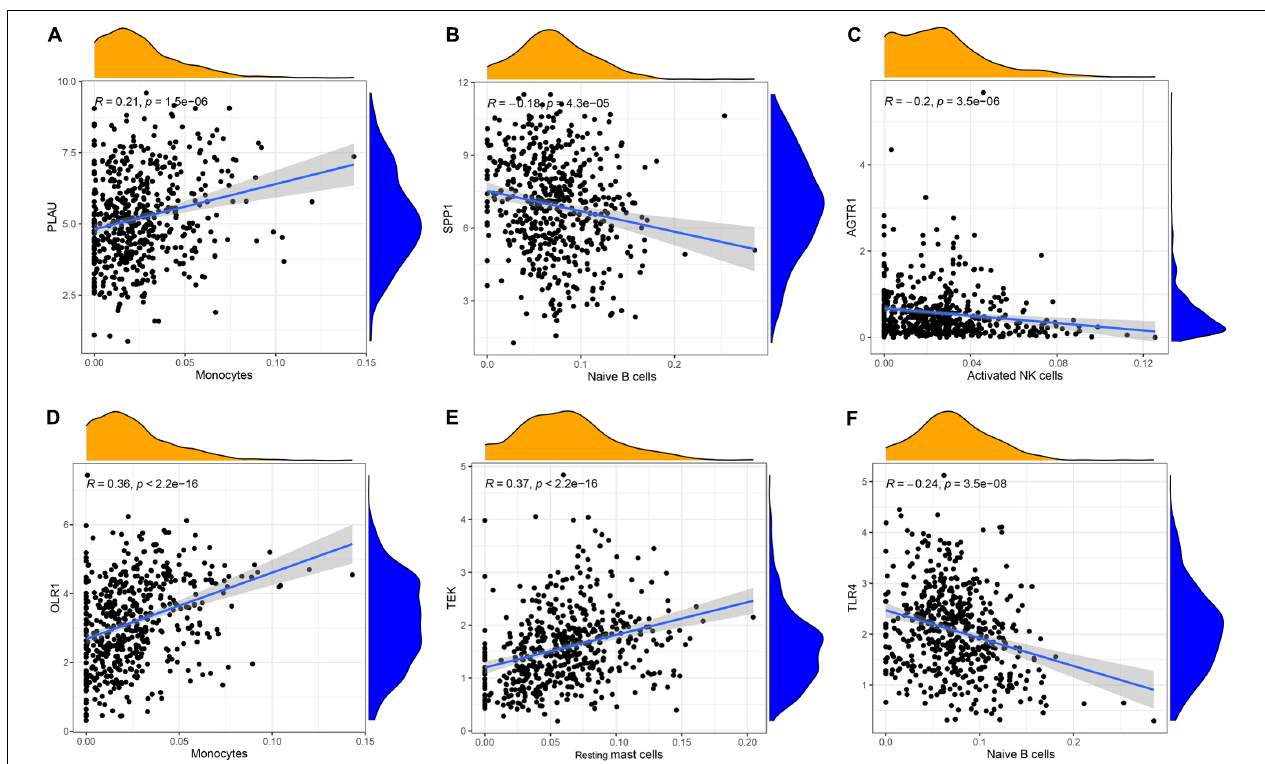
FIGURE 5 | The relationship between IRGs and TILs in LUAD progression. (A–C) PLAU, OLR1, and TEK were the most strongly positively related to the proportions of monocytes ( R = 0.21), monocytes ( R = 0.36), and resting mast cells ( R = 0.37), (D–F) whereas SPP1, AGTR1, and TLR4 were the most strongly negatively associated with the distributions of naive B cells ( R = –0.18), activated NK cells ( R = –0.2), and naive B cells ( R = –0.24),